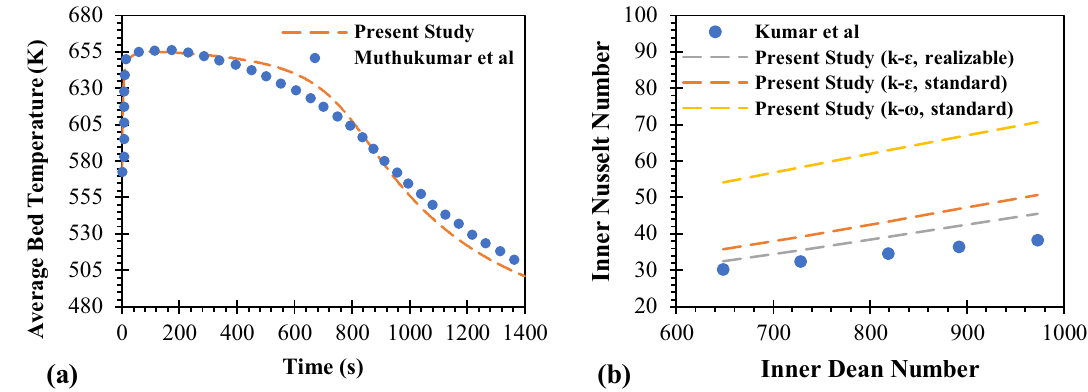
Figure 3. Model validation. ( a ) Code validation of the Mg 2 Ni metal hydride reactor by the comparison of present study and experimental works from Muthukumar et al. 52 , and ( b ) validation study of the turbulence model in helical tube by the comparison of present study and Kumar et al. 54